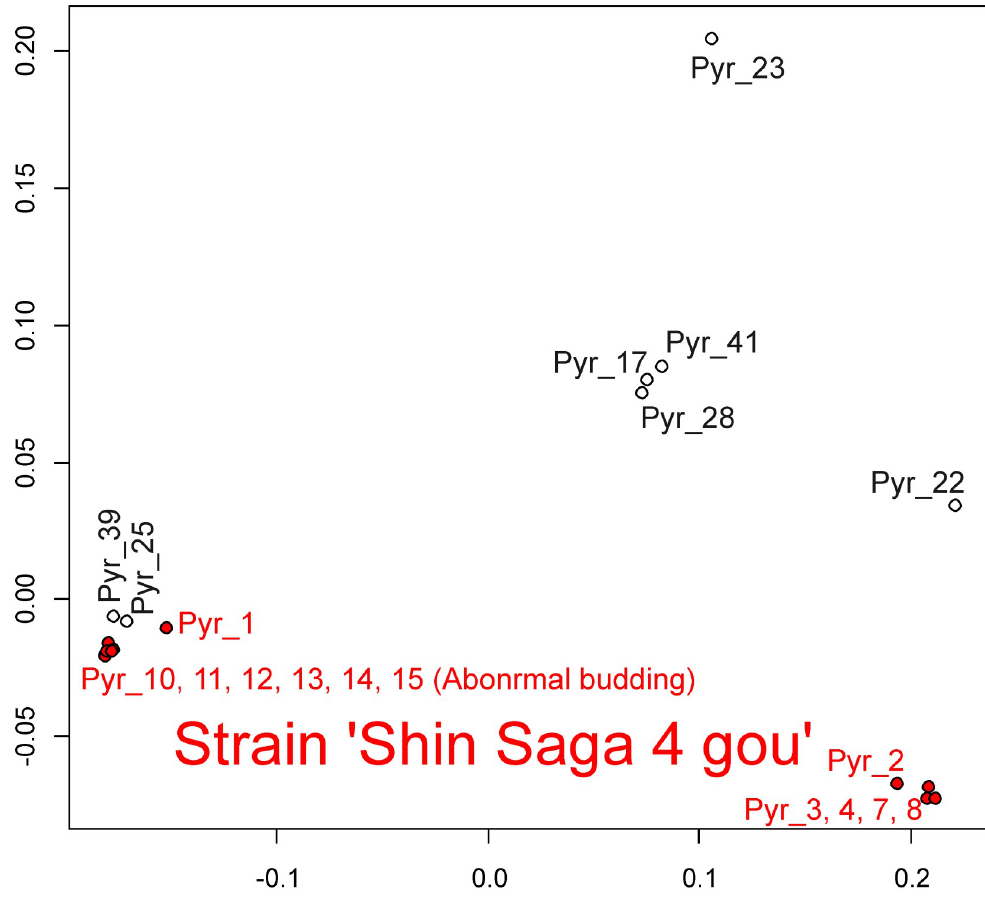
Fig 8. Multidimensional scaling representation using nuclear DNA data of 19 Pyropia yezoensis samples belonging to the cluster A. Two-dimensional data were obtained in this analysis. Members of the strain ‘Shin Saga 4 gou’ were shown in